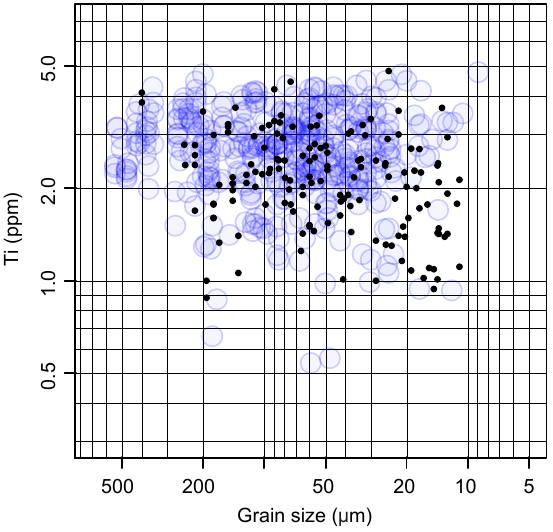
Figure 8. Ti vs. grain size for Gaunt Creek samples. Samples at structural distances < 160m from the fault are shown in black (mainly ultramylonites), while mylonites and protomylonites are plotted in transparent blue. The trend in the samples close to the fault suggests that late recrystallization (as indicated by finer grain size) occurred at conditions where lower concentrations of Ti were stable. Only partial equilibration of Ti-in-quartz values was achieved during recrystallization of fine grains in the ultramylonite. Away from the fault there is no general trend of fine grains having lower Ti